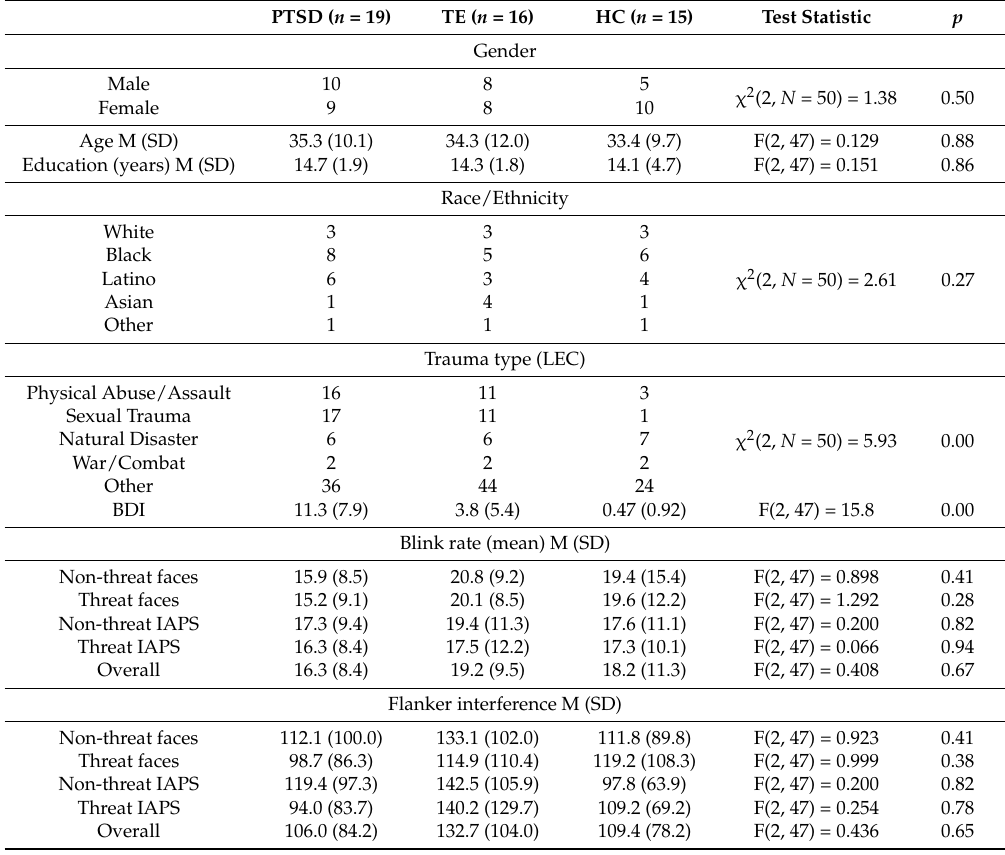
Demographic, clinical, physiological, and behavioral information and comparisons among participants. PTSD ( n =